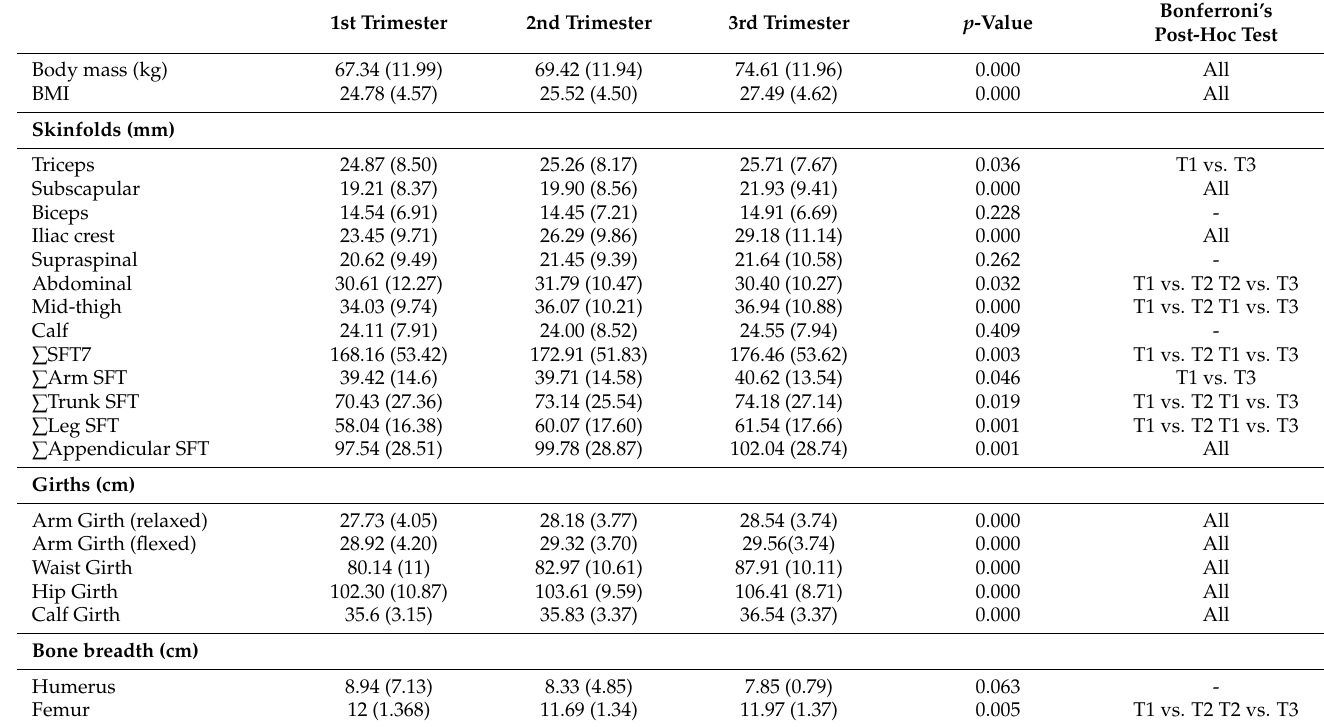
Table 2. Differences in skinfold, circumference, diameter and BMI for the three trimesters during